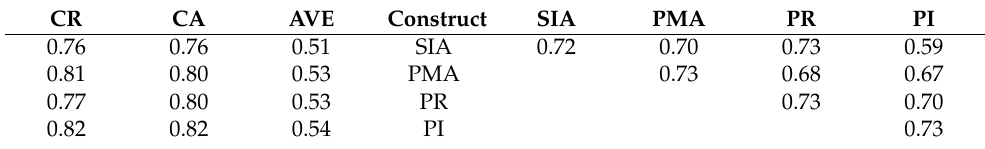
Table 3. Reliability and Validity Measures of the Measurement Model.